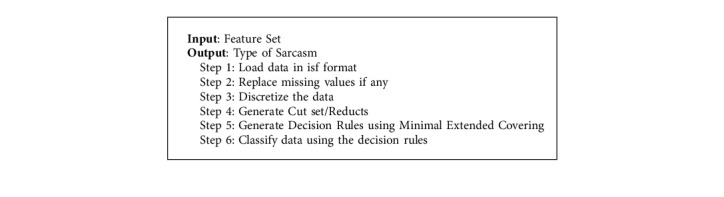
Rough set algorithm.